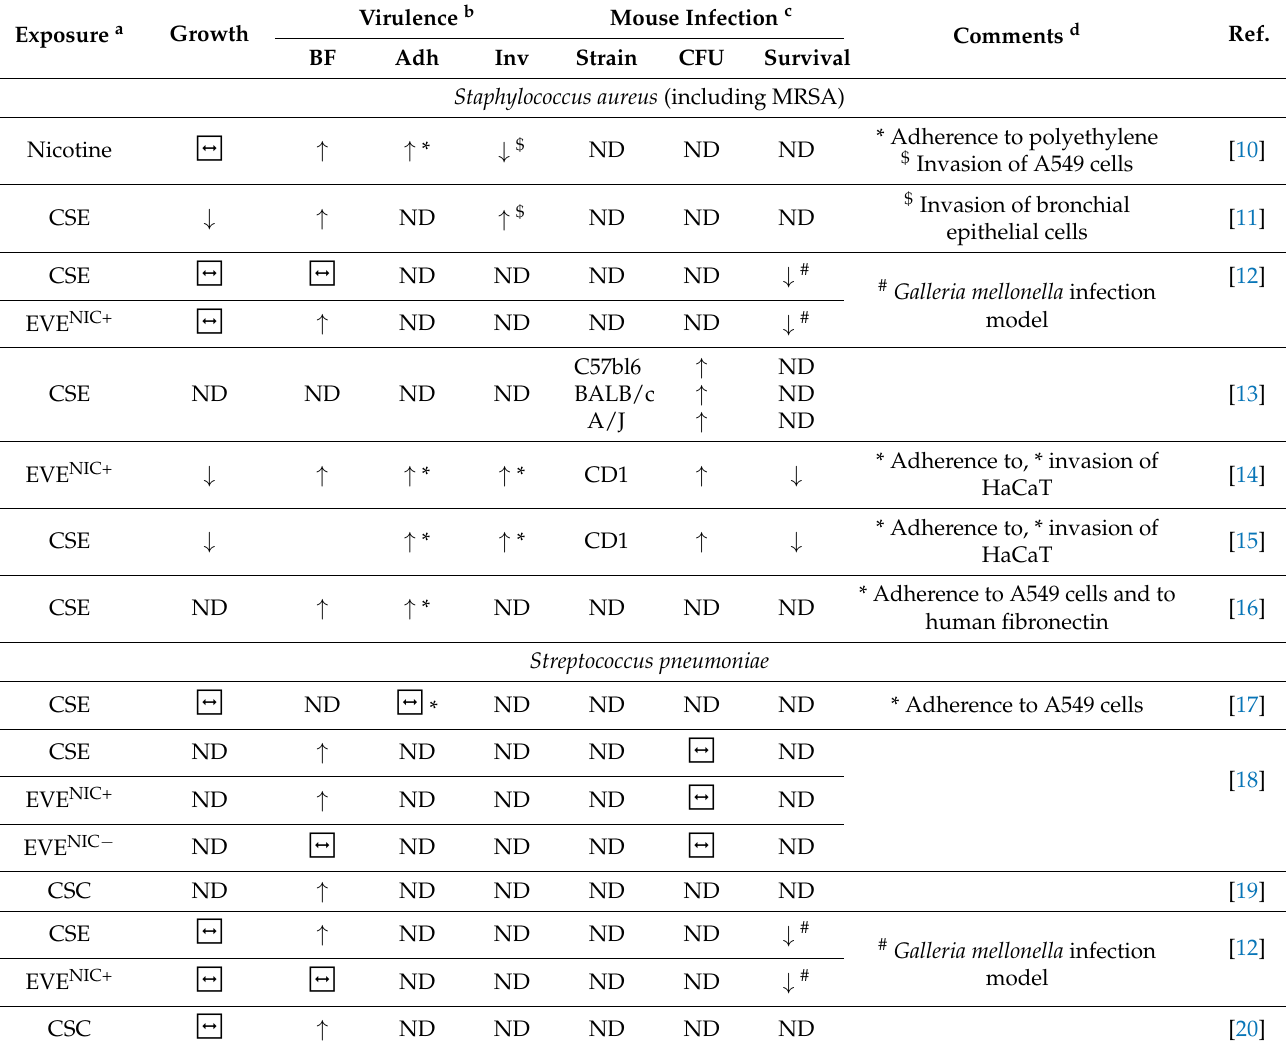
Table 1. Effects of CS/EV exposure on pathogen virulence examined in vitro and in vivo.